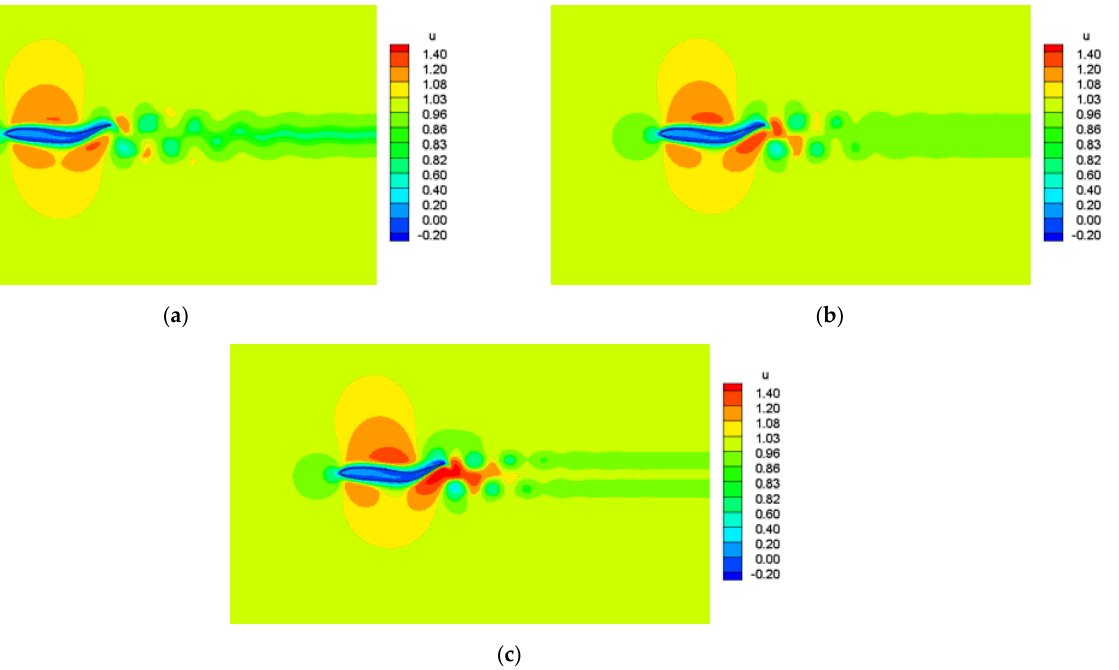
Figure 10. Contours of velocity along x ‐ direction at different Reynolds numbers. ( a ) 𝑅𝑒 (cid:3404) 5000 ; ( b ) 𝑅𝑒 (cid:3404) 50,000 ; ( c ) 𝑅𝑒 (cid:3404) 500,000 .